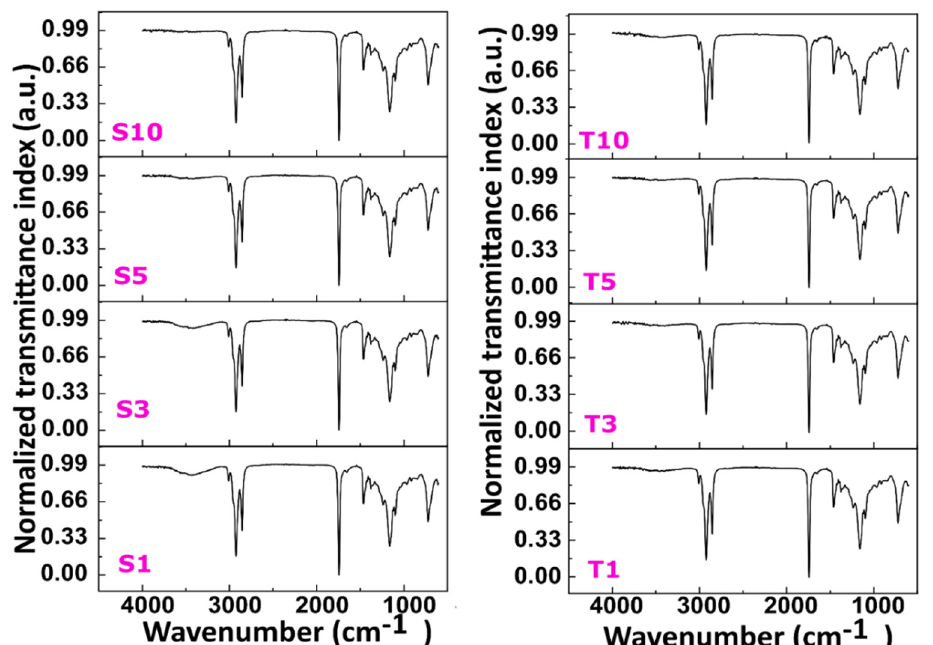
Figure 8. FTIR spectra of oleogels. The details of abbreviations used are provided in Section 4.2 (Table 5).